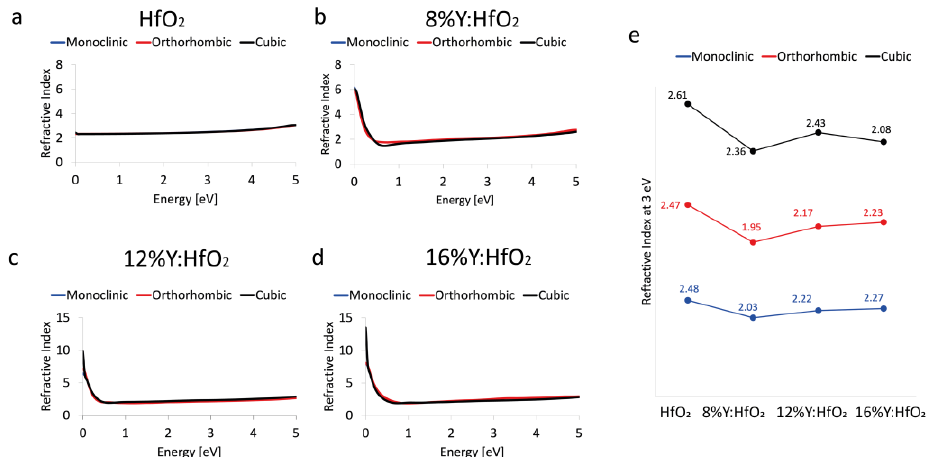
Figure 5. Refractive Index. Refractive index of monoclinic P2 1 /c (blue curve), orthorhombic Pca2 1 (red curve), and cubic Fm 3̅ m (black curve) polymorphs evaluated between 0 and 5 eV of HfO 2 ( a ), 8% Y:HfO 2 ( b ), 12% Y:HfO 2 ( c ), and 16% Y:HfO 2 ( d ). Schematic trend of n at 3 eV as a function of the crystalline phase and Y content ( e ).